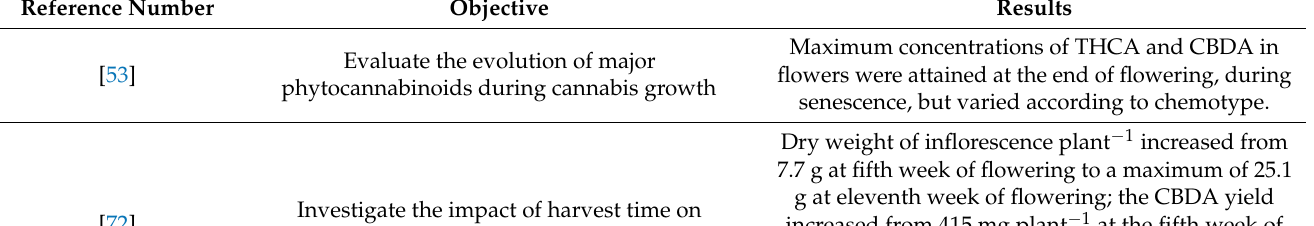
Table 2. Nonexhaustive summary about the most relevant studies in relation to the effects of ontogeny on phytocannabinoid